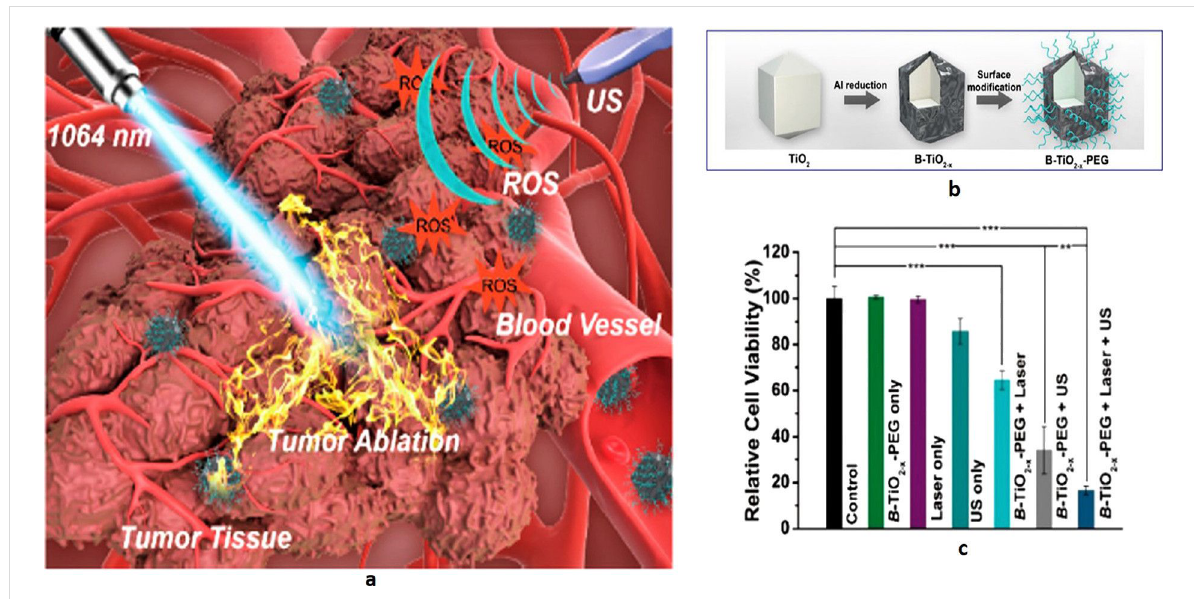
Figure 7: (a) Schematic illustration of synergistic SDT and PTT assisted by B-TiO 2 − x -PEG for tumor eradication. (b) Schematic of the fabrication of B-TiO 2 − x by aluminum reduction. (c) Relative cell viability of 4T1 cells after different treatments, including control (without treatment), B-TiO 2 − x -PEG only, laser only, US irradiation only, B-TiO 2 − x -PEG combined with laser irradiation, B-TiO 2 − x -PEG combined with US irradiation, and B-TiO 2 − x -PEG combined with laser/US co-irradiation (*** denotes P < 0.001). (Figure 7 was adapted from [115], Copyright 2011 ACS Publications. This content is not subject to CC BY 4.0).